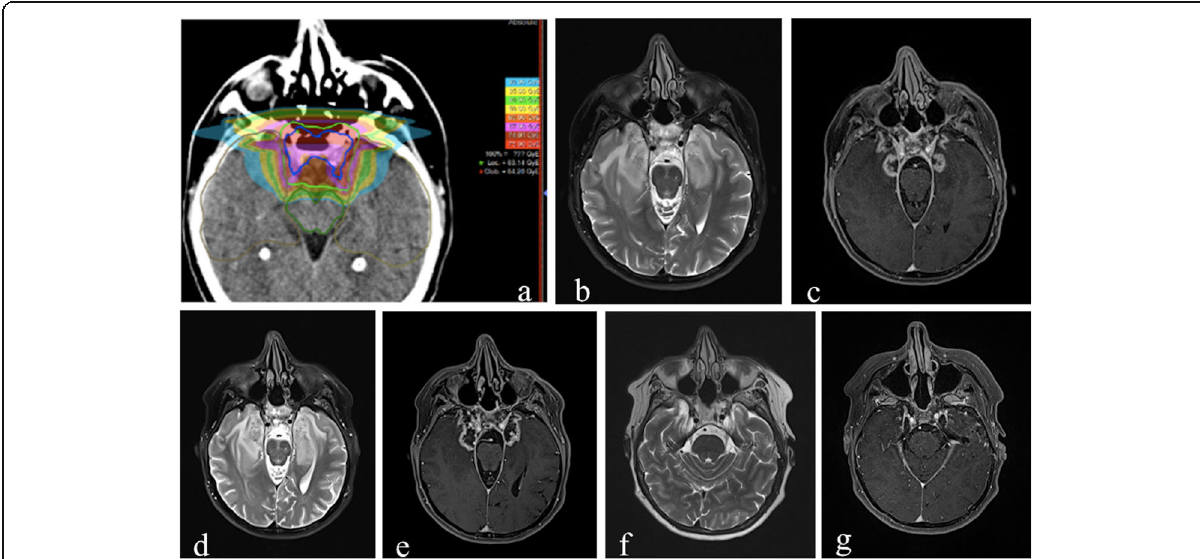
Fig. 6 MRI performed in a patient who underwent 74 Gy proton-beam therapy for skull base chordoma. Radiation treatment field ( a ). After 18 months from the end of the treatment, axial T2-weighted image ( b ) shows diffuse hyperintensity involving predominantly white matter in temporal lobes and axial postcontrast T1-weighted image ( c ) demonstrates irregular-shaped enhancing areas in both mesial and polar temporal regions. The morphology of the enhancing lesions shown is in accordance with the radiation treatment field shown in ( a ). At the following follow-up, performed 21 months after the end of the treatment, axial T2-weighted image ( d ) and axial postcontrast T1-weighted image ( e ) show that the lesions and the surrounding edema shown in ( b ) and ( c ) have increased in volume. The morphology of the enhancing lesions shown remains in accordance with the radiation treatment field shown in ( a ). After 48 months from the end of the treatment, T2-weighted image ( f ) and axial T1 post-contrast-weighted image ( g ) show the evolution of the alterations, demonstrating focal atrophic changes in both temporal poles according with the evident decrease of extension of the contrast enhancing